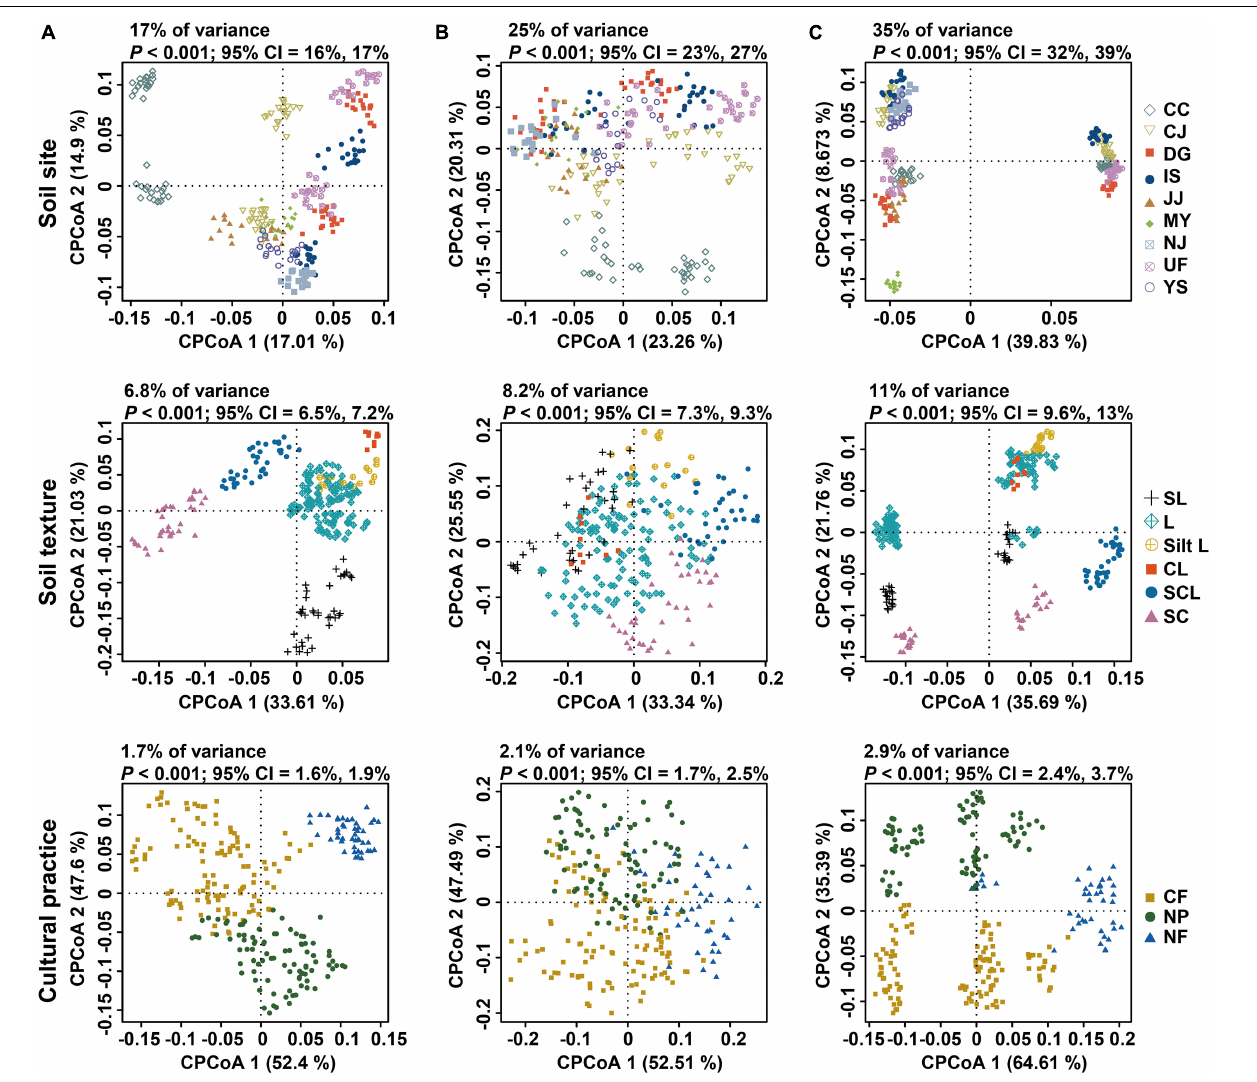
FIGURE 2 | Constrained principal coordinate analysis of bacterial, archaeal, and fungal communities in rice paddy fields. Variations in (A) bacterial, (B) archaeal, and (C) fungal communities constrained by sampling site (upper panel), soil texture (middle panel), and cultural practice (bottom panel). Cumulative sum scaling (CSS)/log-transformed reads were used to calculate Bray–Curtis distances. Colors and shapes indicate sampling sites, soil textures, and cultural practices, respectively. CC, Chuncheon; CJ, Cheongju; DG, Daegu; IS, Iksan; JJ, Jinju; MY, Miryang; NJ, Naju; UF, University Farm (Suwon); YS, Yesan; SL, sandy loam; L, loam; Silt L, silt loam; CL, clay loam; SCL, silt clay loam; SC, silty clay; CF, conventional farming (managed with both pesticides and fertilizers); NF, no fertilizers (managed with only pesticides); NP, no pesticides (managed with only